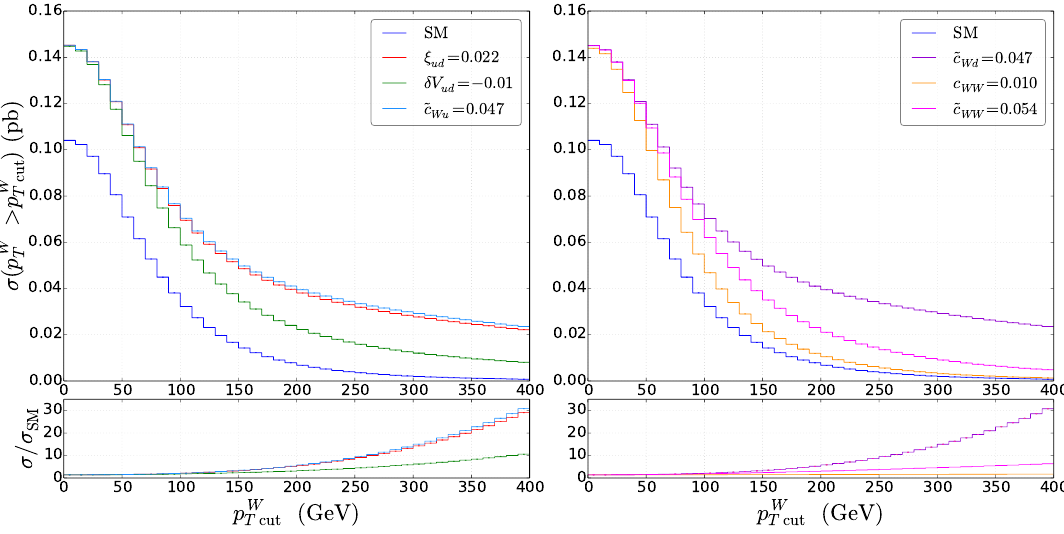
p > p W , at S = 14 TeV. The blue line denotes the SM T T cut